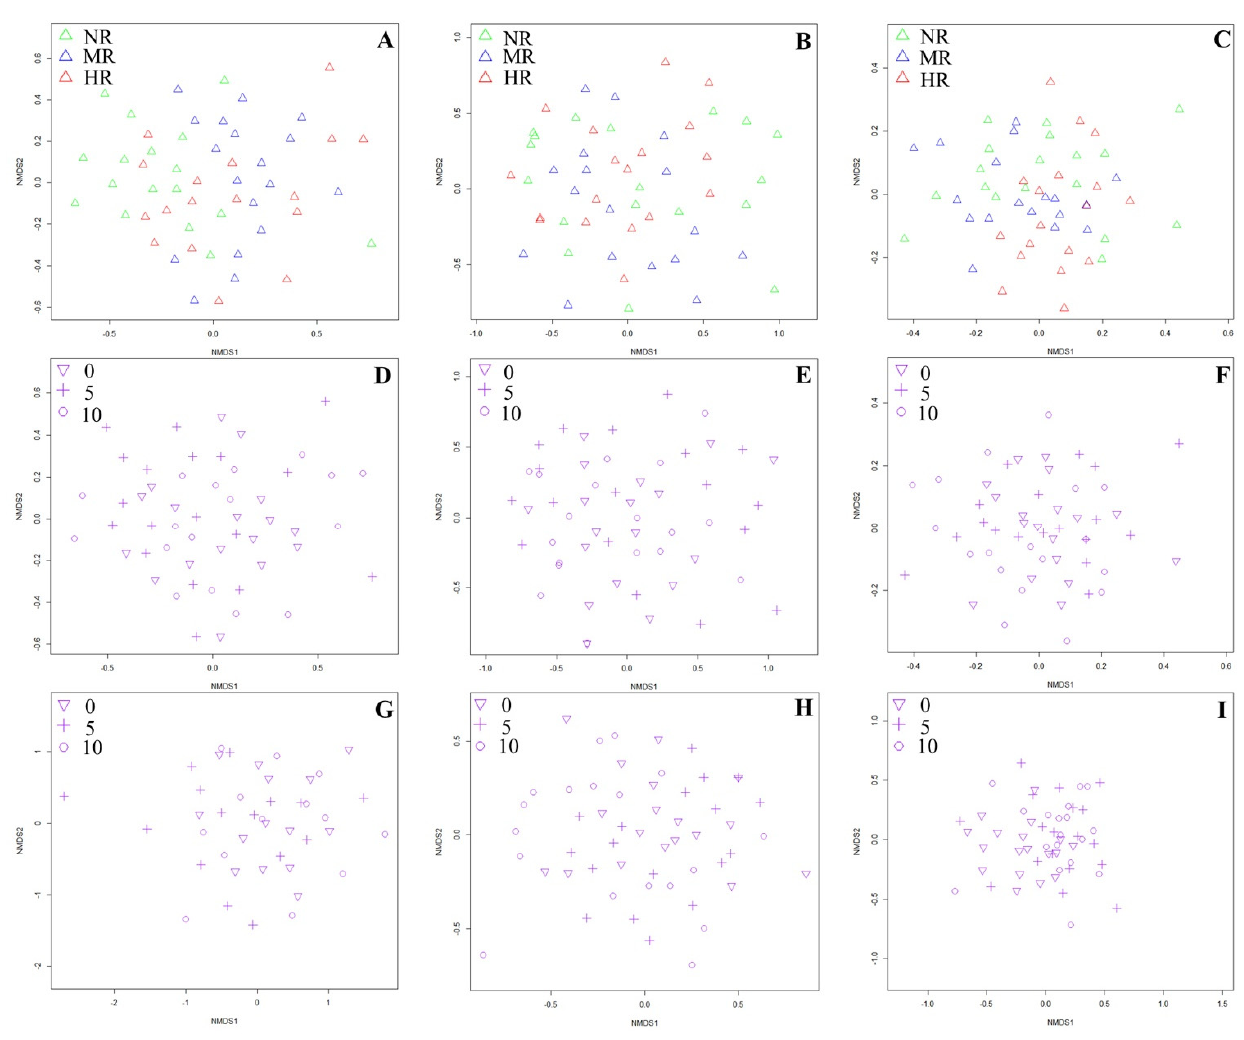
Figure A1. Non-metric multidimensional scaling (NMDS) based on Bray–Curtis distances visualizing the distributions of different revetment types and distances: ( A ) Distribution of three revetment types for soil macrofauna in autumn; ( B ) distribution of three revetment types for microarthropods in autumn; ( C ) distribution of three revetment types for the hygrophilous mesofauna in autumn; ( D ) distribution of three distances for soil macrofauna in autumn; ( E ) distribution of three distances for microarthropods in autumn; ( F ) distributions of three distances for the hygrophilous mesofauna in autumn; ( G ) distribution of three distances for soil macrofauna in summer; ( H ) distribution of three distances for microarthropods in summer; ( I ) distributions of three distances for the hygrophilous mesofauna in summer.